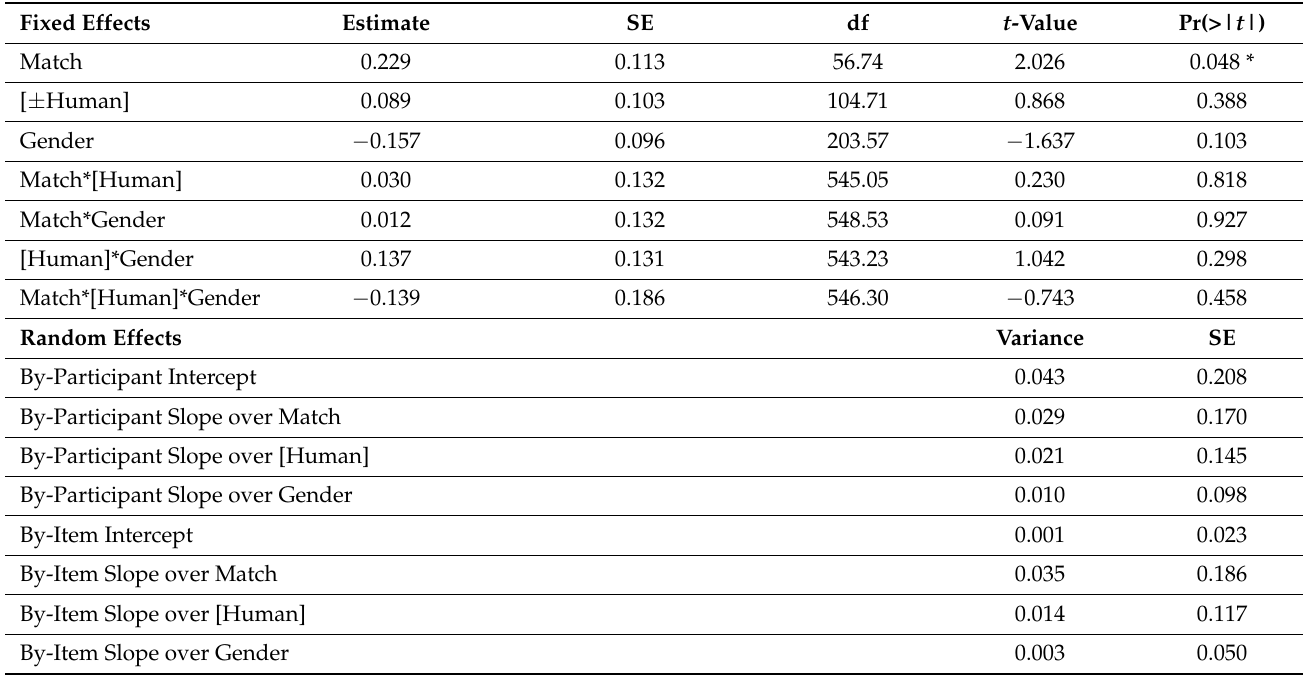
Table 8. Linear mixed-effects model, Region 7-SPR, L1